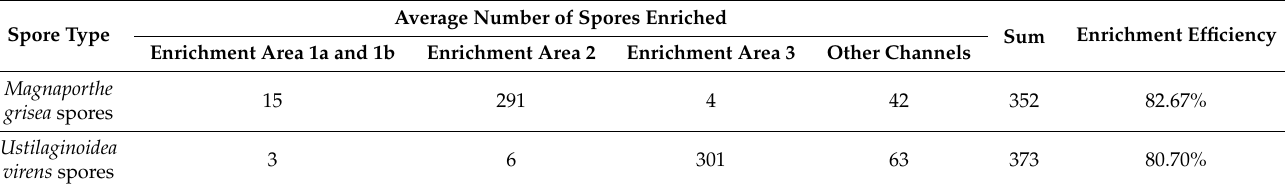
Table 1. Statistical results of spore enrichment